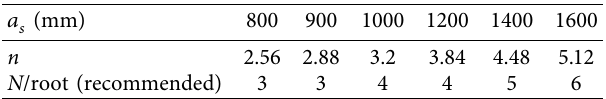
Table 1: Relationship between number of anchor cables and row spacing.